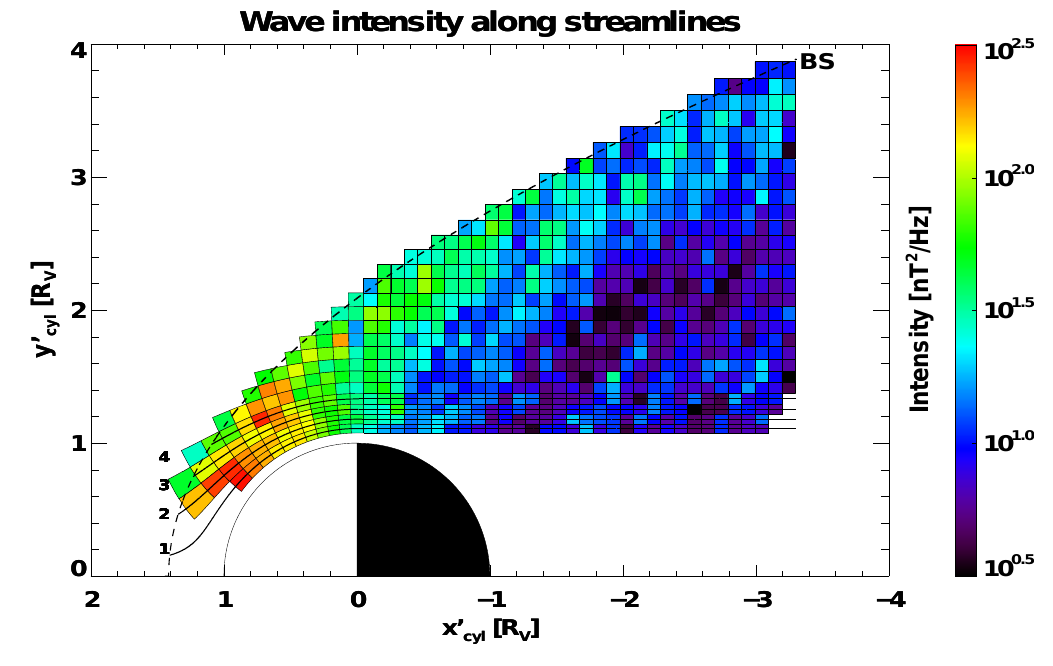
Fig. 9. Intensity along streamlines. The intensities connected to the different positions along any streamline are averaged over the neigh- bouring streamlines and velocity potential lines. Solid lines display magnetosheath streamlines which are also